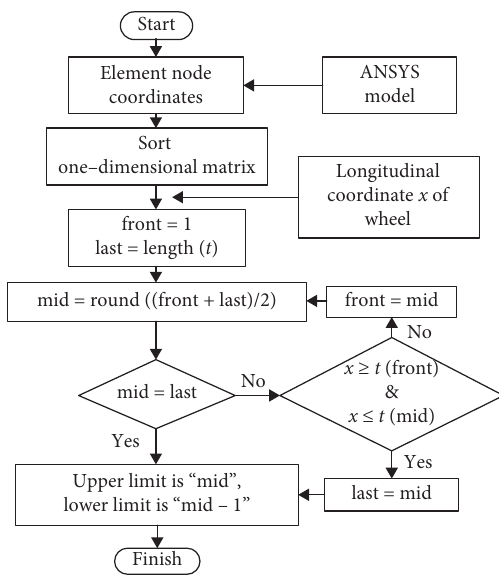
Figure 4: Flowchart of improved binary